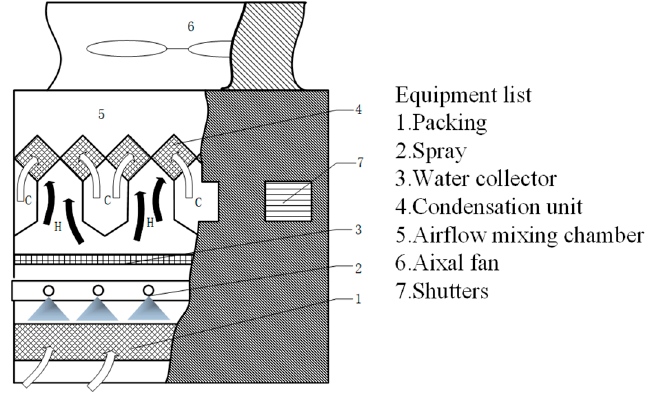
Figure 4. Schematic diagram of a cooling tower.